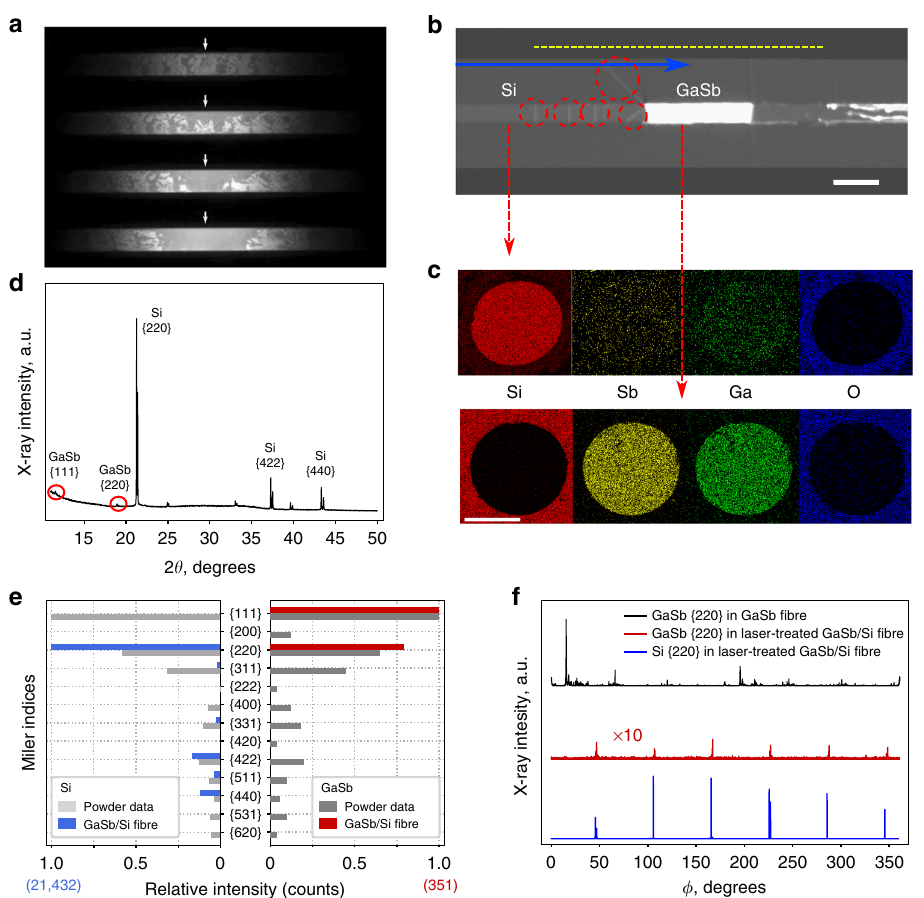
Fig. 2 Laser treatment of composite fi bres; a images of thermal emission during initial heating of the fi bre; solid Si is brighter than liquid GaSb/Si alloy due to higher emissivity, b XCT of fi bre after heating and translation to accumulate GaSb (scale bar 350 µ m), c EDX elemental maps of silicon and GaSb regions after translation; red arrows show where cross-sections were prepared (scale bar 100 µ m), d θ -2 θ of the segregated fi bre, e intensities of X-ray peaks after anneal (blue-Si, red-GaSb), compared to powder fi les (grey). The maximum numbers of counts for the fi bre are in parentheses ( f ) {220} peak intensities during a slow axial